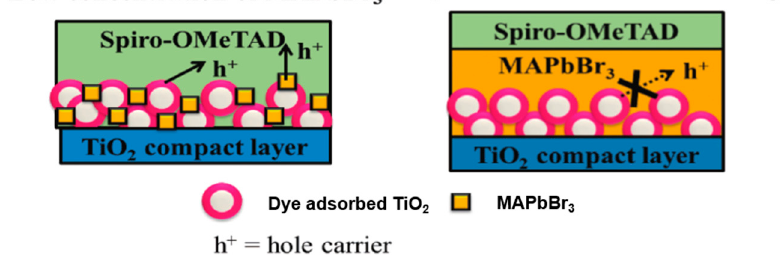
Figure 11. Schematic representation of proposed electron transport mechanism [104].